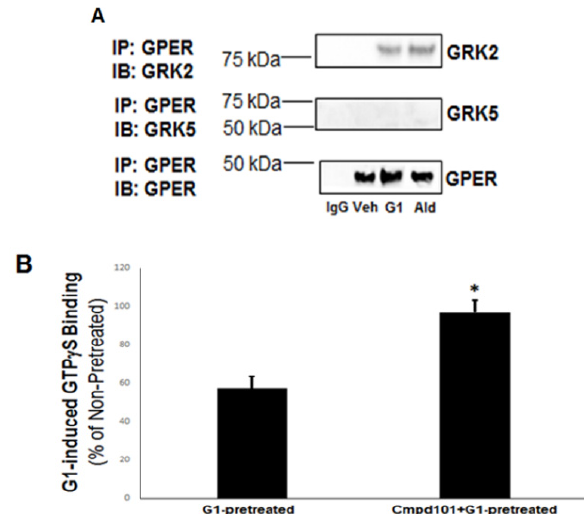
Figure 2. GRK2 but not GRK5 desensitizes G protein-coupled estrogen receptor (GPER) in cardiac myocytes. ( A ) Immunoblotting for GRK2 and GRK5 in GPER immunoprecipitates from H9c2